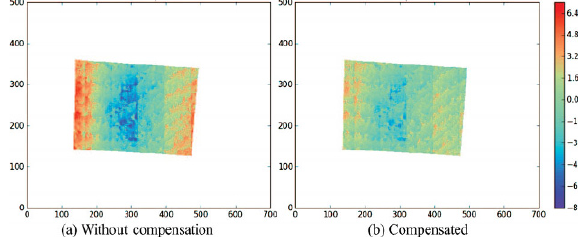
Fig. 1 Left: observation errors in Kinect output. Right: compensated values using our